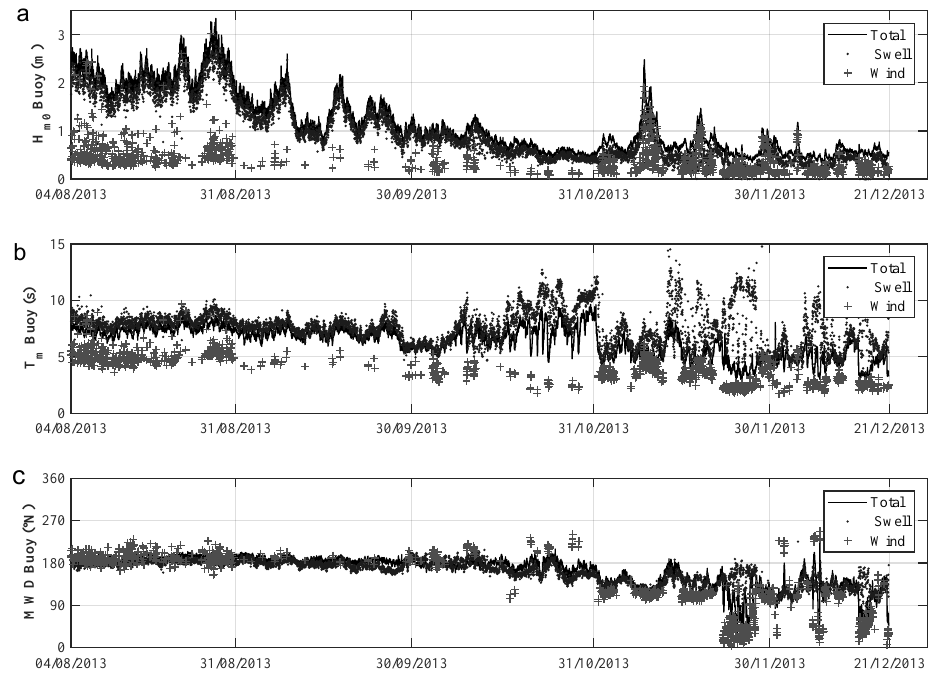
Figure 8. Time series plot of wave characteristics estimated from partitioned spectra: significant wave height, wind wave and swell height ( a ); mean wave period, wind wave and swell mean wave period ( b ); and mean wave direction, wind wave and swell mean wave direction ( c